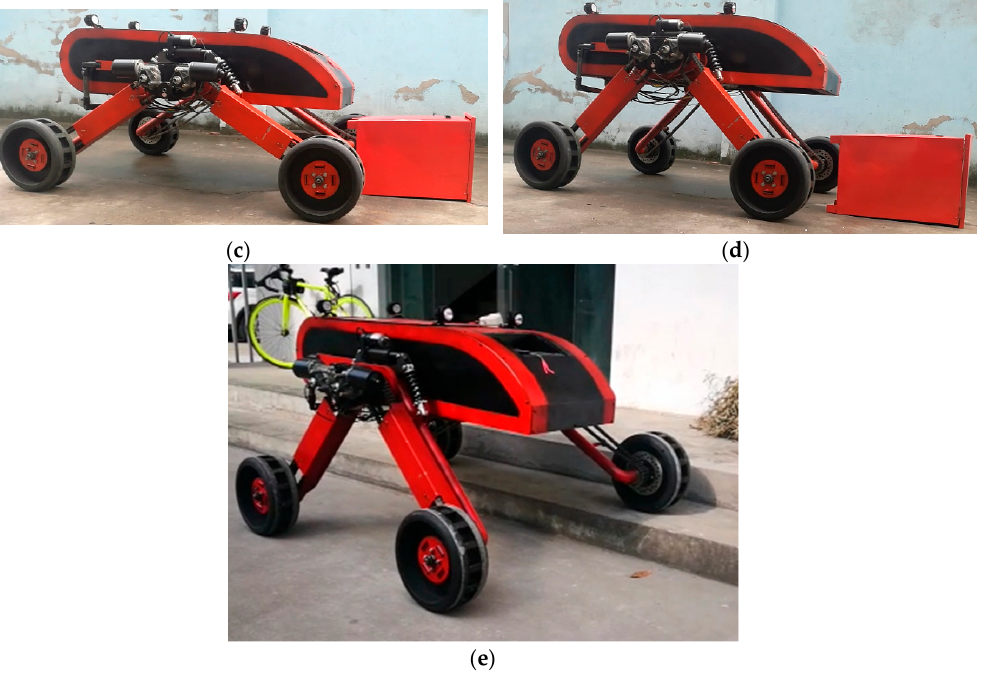
Figure 13. Basic field experiments illustration: ( a ) Slope; ( b ) Unilateral obstacle; ( c ) Low ground clearance; ( d ) High ground clearance; ( e ) Leveled attitude.